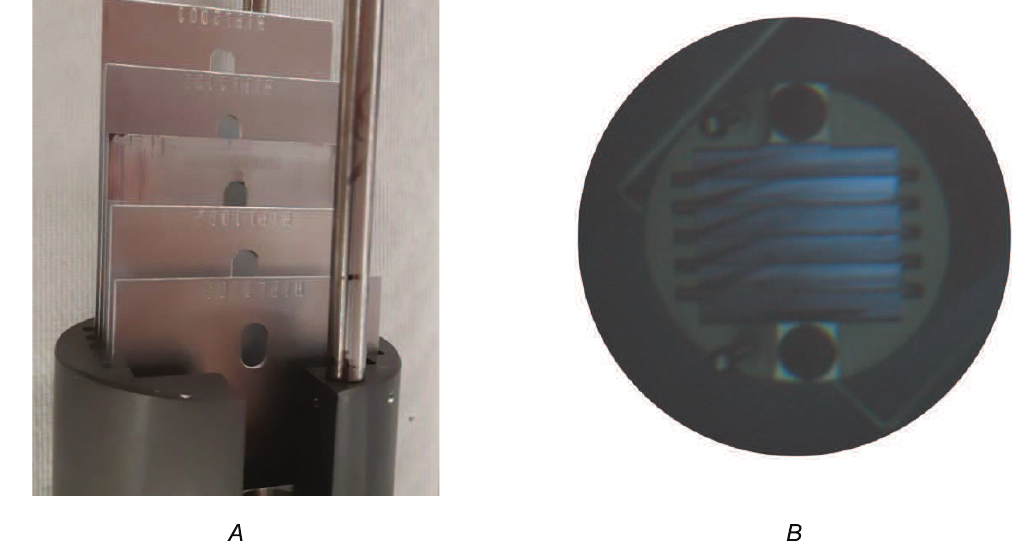
Fig. 4. (A) FUTURE-5 basket with plates, (B) fuel plates in the in-pile section (IPS)